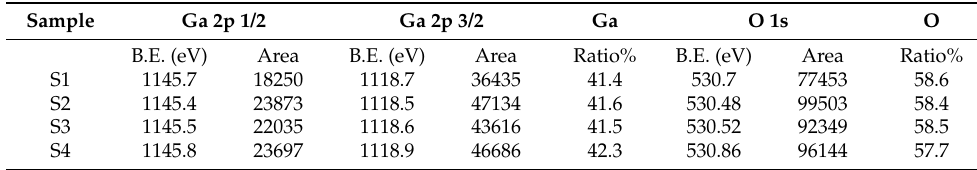
Table 2. The O 1s and Ga 2p atomic percentages and bonding analysis of S1, S2, S3, and S4. (In table,